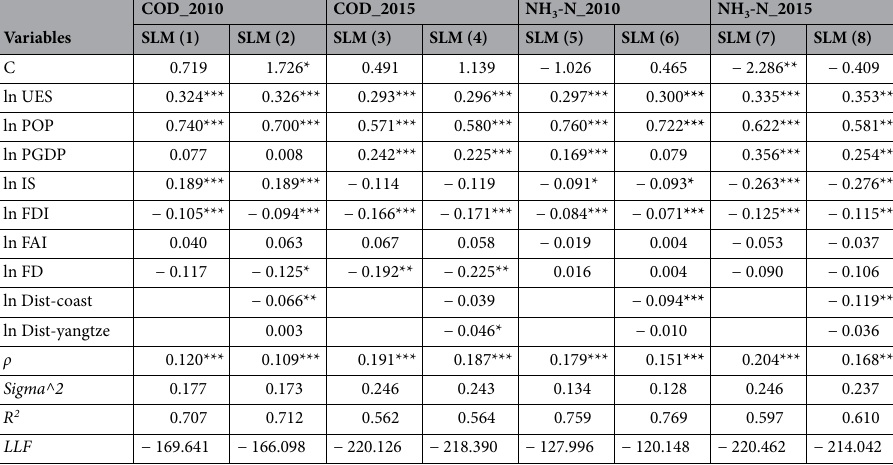
Table 3. Estimation results for associated effects based on contiguity edges matrix. ***P < 0.01, **P < 0.05 and *P < 0.1.